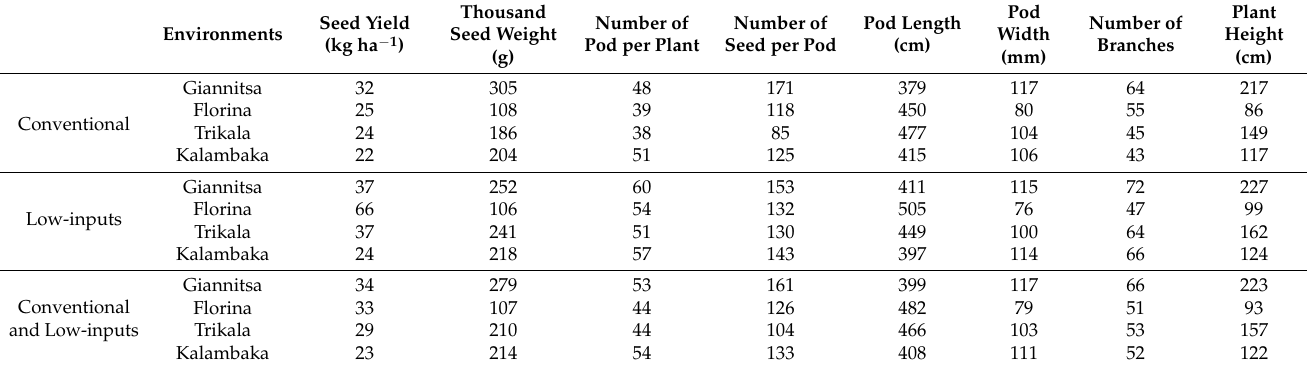
Table 2. Trait stability index across environments for two farming systems: seed Yield (kg ha − 1 ), thousand seed weight (g), number of pod per plant, number of seed per pod, pod length (cm), pod width (mm), number of branches and plant height